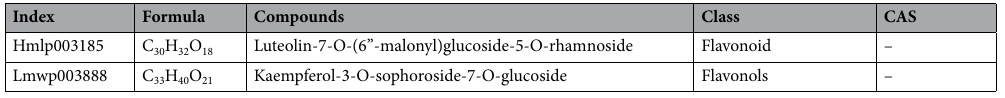
Table 1. Flavonoids in soybeans seeds and